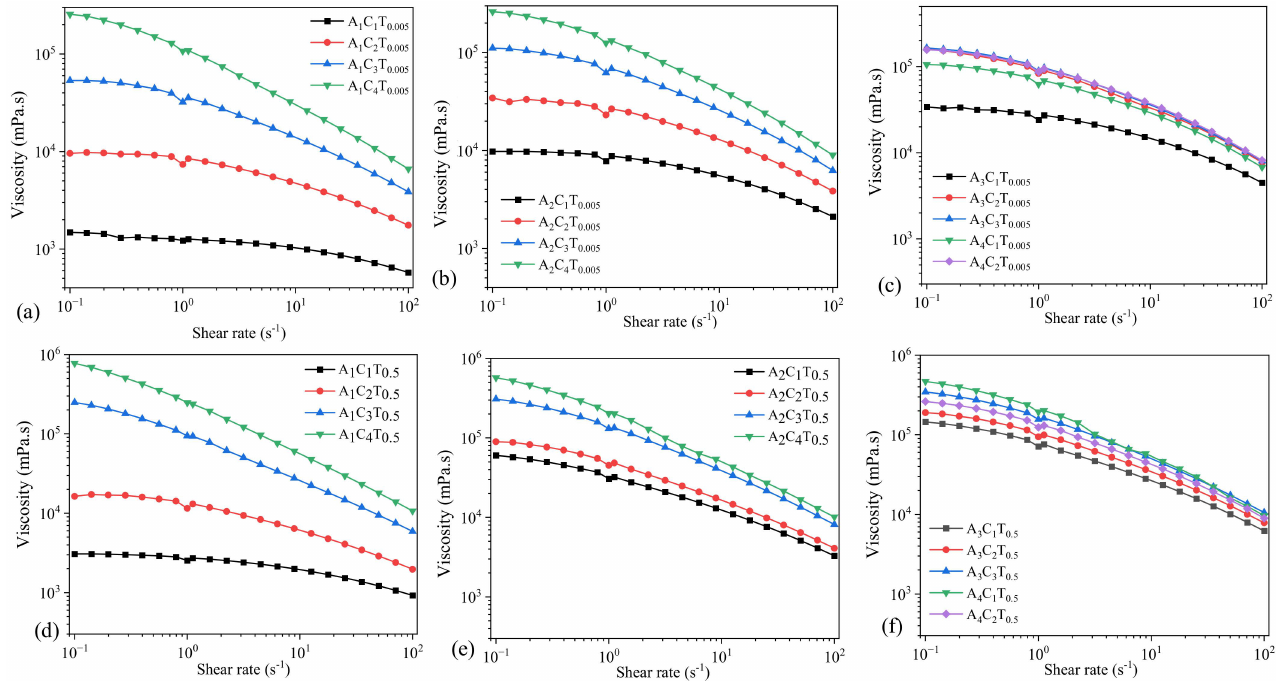
Figure 2. Viscosity of compositions composed with various percentages of alginate (1–4%) and CMC (1–4%) with ( a – c ) 0.005% of TO-NFC and ( d – f ) 0.5% of TO-NFC.